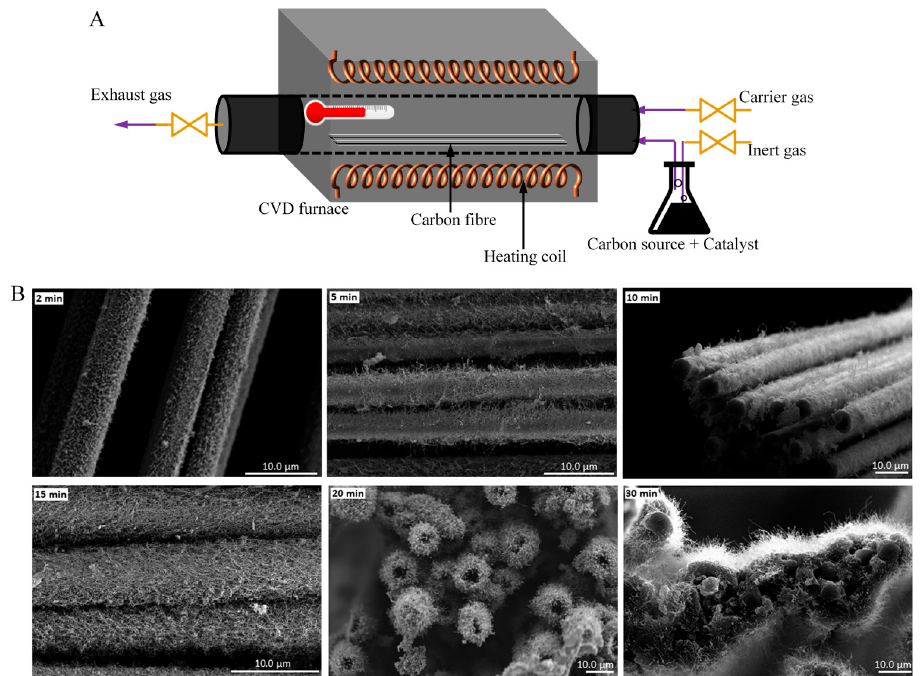
Figure 5. ( A ) Schematic diagram of a floating catalyst CVD. ( B ) SEM images of CNT morphology on CF surface as a function of time under 700 °C temperature and 100 mL/min carrier gas flow rate. Reprinted with permission from ref. [117], Copyright 2014 Society of Plastics Engineers.